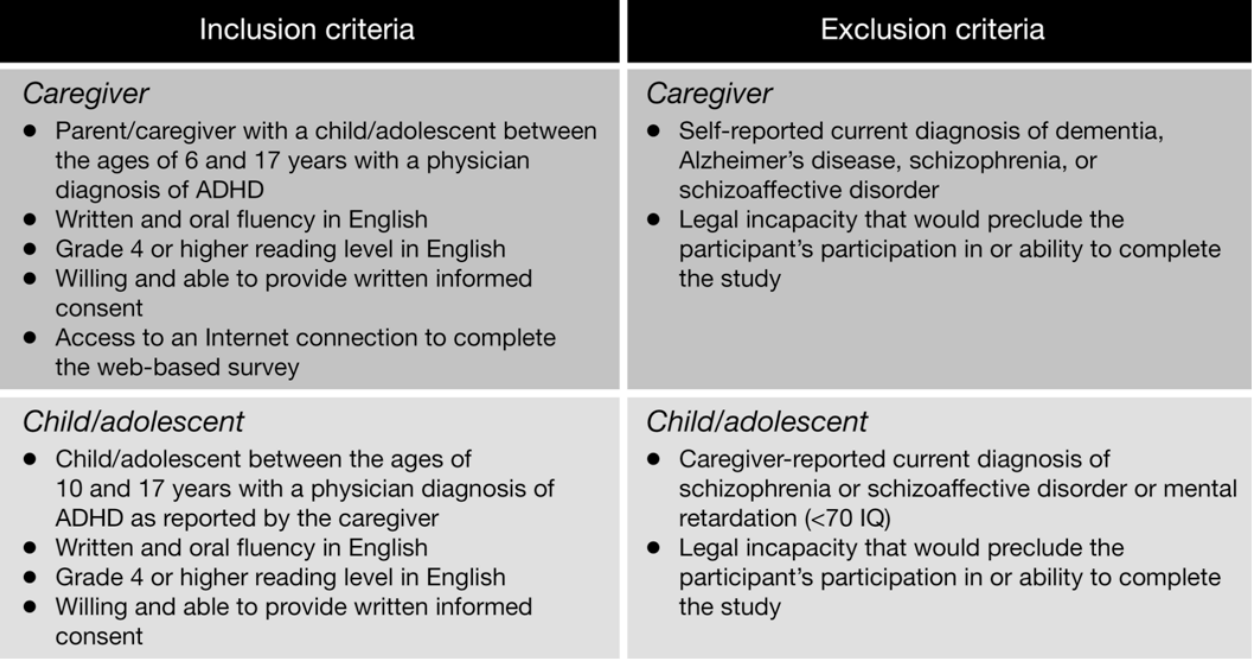
Figure 1. Inclusion and Exclusion Criteria for Caregivers and Children/Adolescents